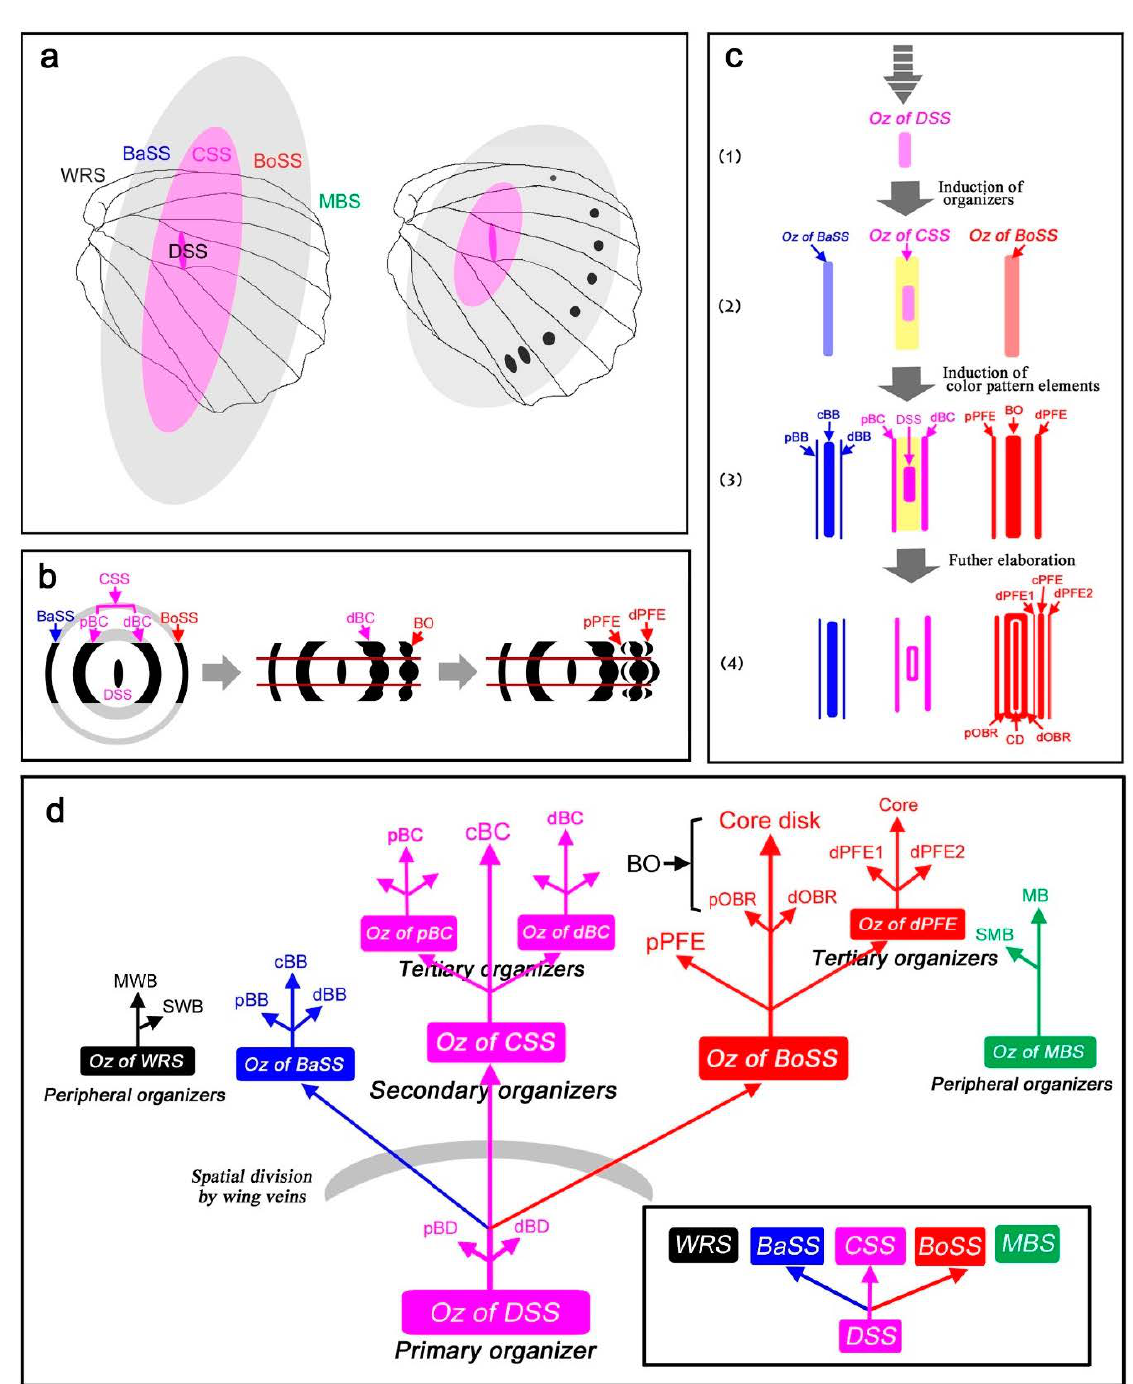
Figure 10. Possible relationships and developmental mechanisms of the color pattern symmetry systems. Oz: organizer, CD: core disk, and OBR: outer black ring. For other abbreviations, see Figure 1b. ( a ) Signals for wing-wide color patterns from the DSS organizer. ( b ) Developmental relationships among the three symmetry systems and parafocal elements. ( c ) Developmental order of the symmetry systems. ( d ) A tree diagram of the developmental relationships among the symmetry systems. The inset summarizes simple relationships among symmetry